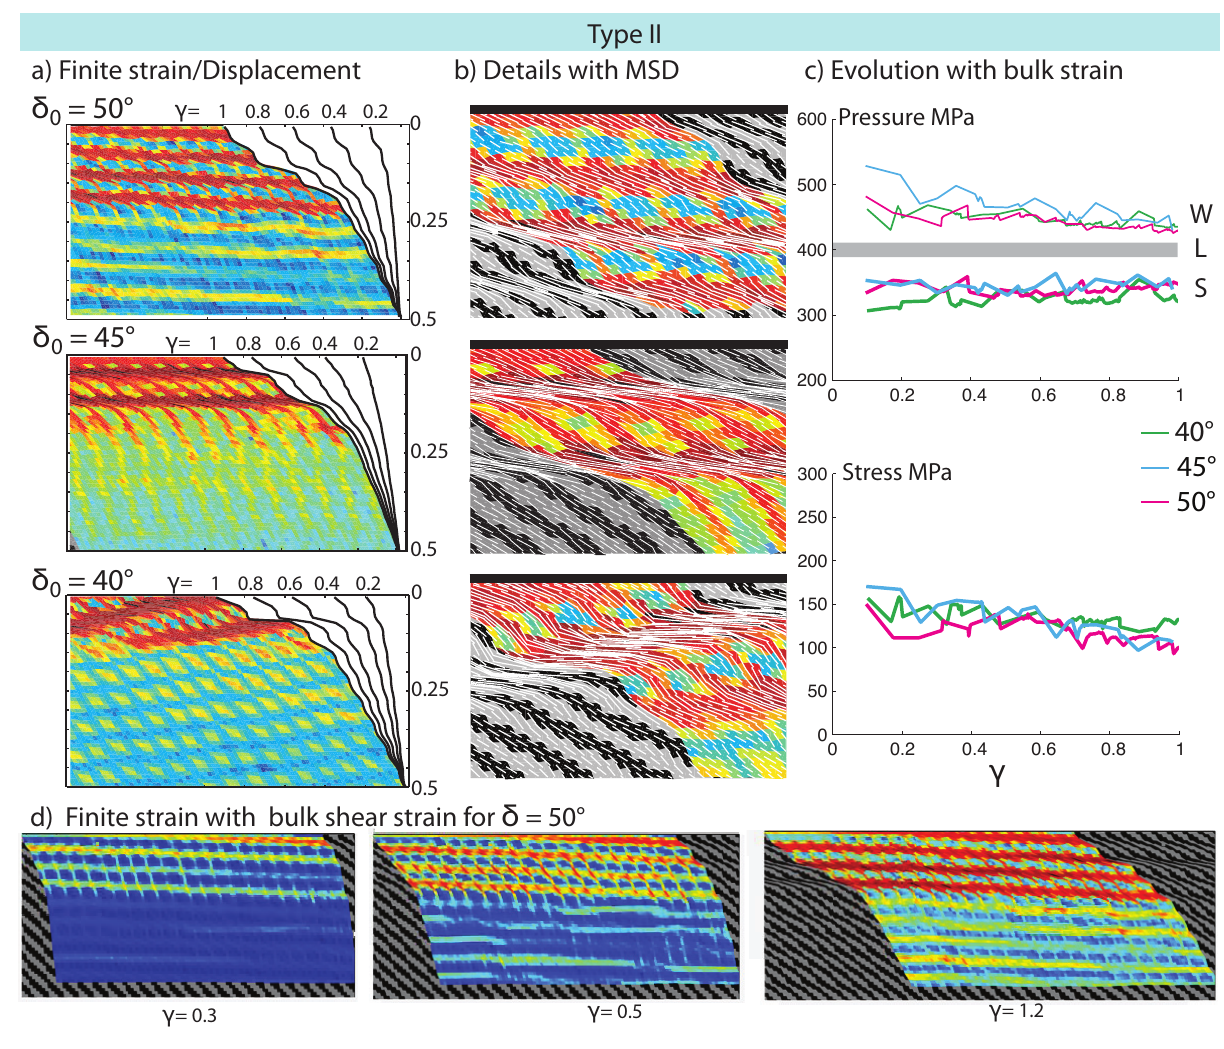
Fig. 5. Type II (a) Strain (colour scale) is maximum in shear bands rather than in weak layers. The deformed profiles for γ respectively equal to 0.2, 0.4, 0.6, 0.8 and 1 indicate that displacement rate decreases with time at depth. (b) In shear bands, MSD tends to be parallel to the bulk shear at large strain. (c) Pressure gap between the weak (W, thin lines) and strong (S, thick lines) as well as the deviatoric stresses decrease with time indicating, strain softening. (d) The evolution of finite strain with time for δ 0 = 50 ◦ indicates that the deeper shear bands are active from the onset of